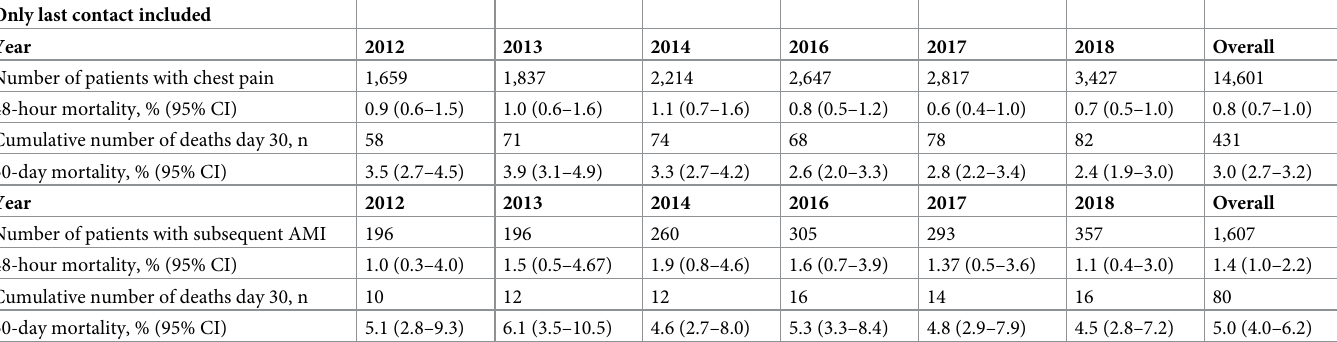
Table 5. Cumulative deaths and mortality estimates for patients with chest pain, and those with a subsequent AMI diagnosis. Note for patients with more than one ambulance contact in the study periods, only the last contact was used. Cumulative number of deaths within 48-hours omitted due to microdata. AMI, acute myocardial